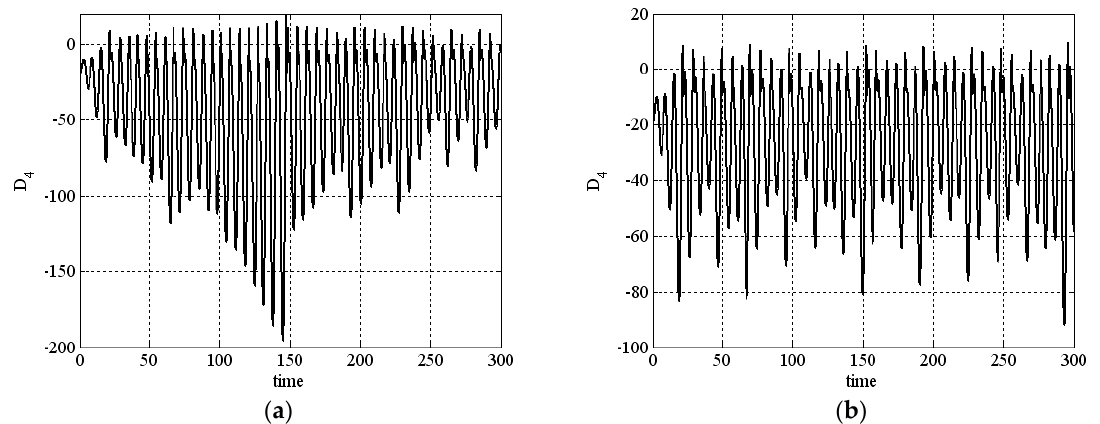
Figure A3. Values of D 4 (see (6)) when ( a ) a = 0.25, b = 3, c = 0.5, d = 0.05, b 1 = 0.2, b 2 = − 0.1, b 3 = b 4 = 0.1; ( b ) a = 0.25, b = 3, c = 0.5, d = 0.05, b 1 = 0.2, b 2 = − 0.3, b 3 = 0.2, b 4 = 0.01.